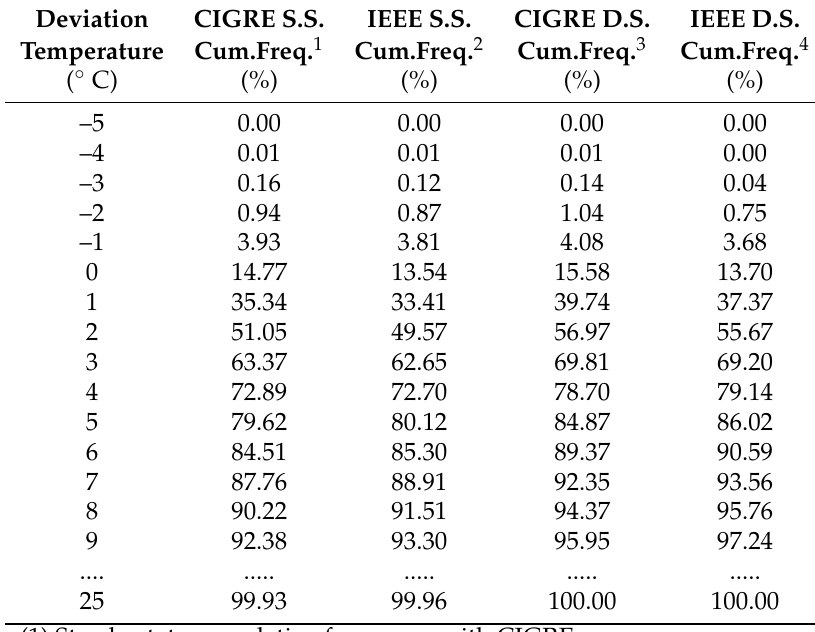
Table 2. Cumulative frequency of differences between temperatures obtained using CIGRE ( T CIGRE c , ss and T CIGRE ) and IEEE ( T IEEE c , ss and T IEEE ) standards and T TMS c for an entire c , ds c , ds